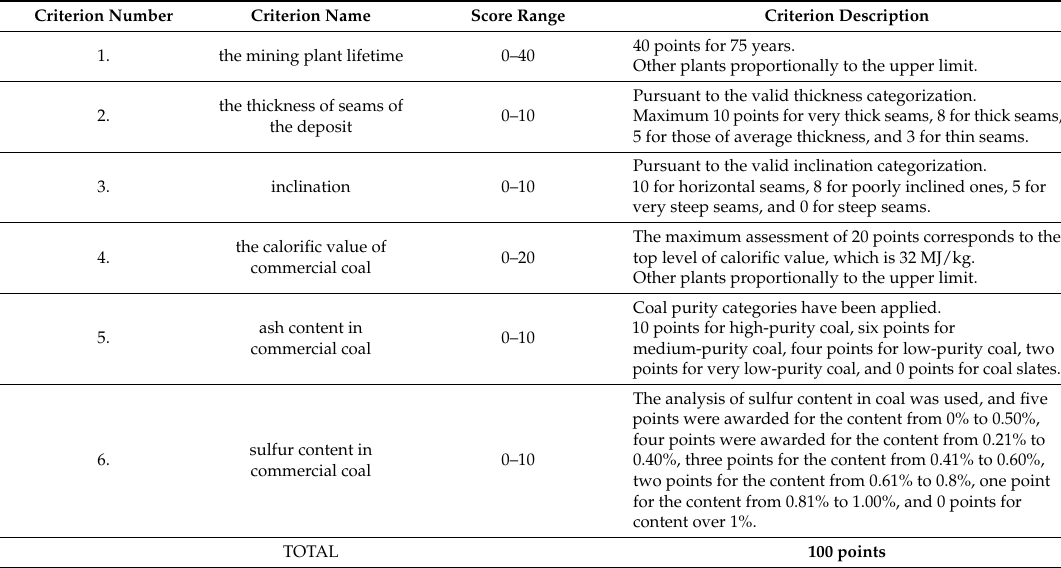
Table 1. The principles for assessing geological and mining